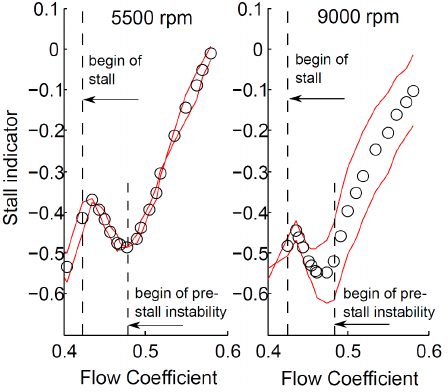
Figure 6. Stall indicator; distribution for each pressure transducer in red—average distribution marked with circles